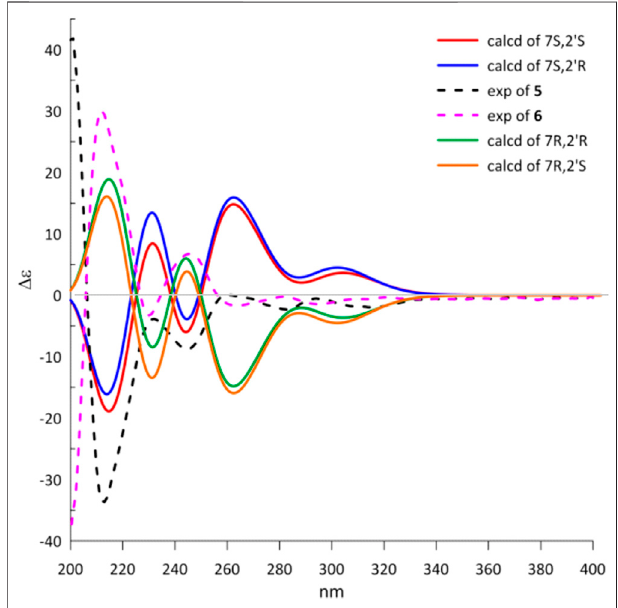
FIGURE 6 | Experimental and calculated ECD spectra of 5 and 6